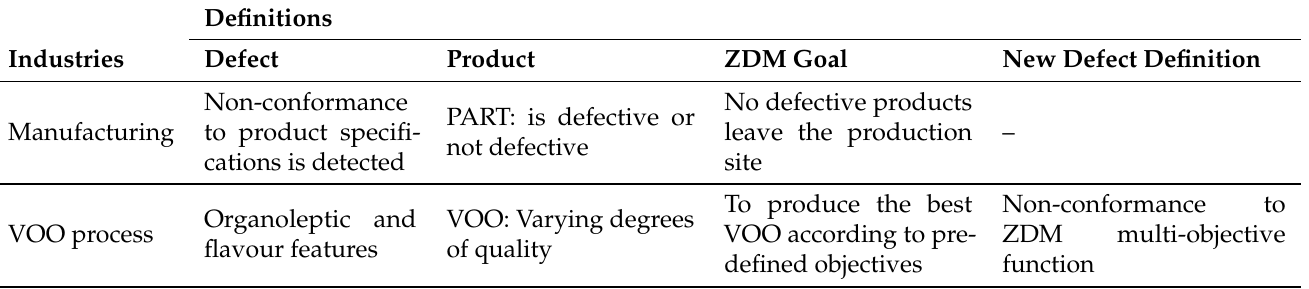
Table 2. ZDM definitions in the manufacturing and VOO